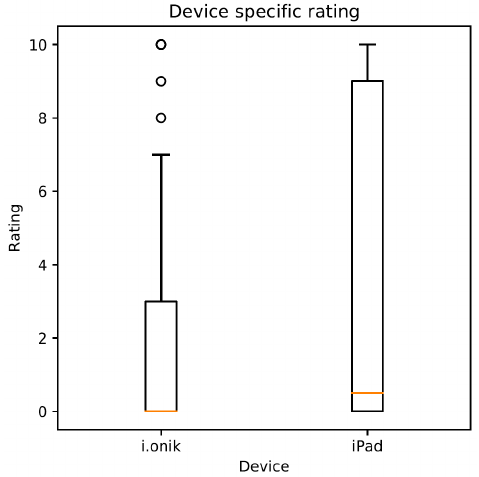
Figure 8. Device specific rating of detection performance (“Rating”) regarding both tablets.